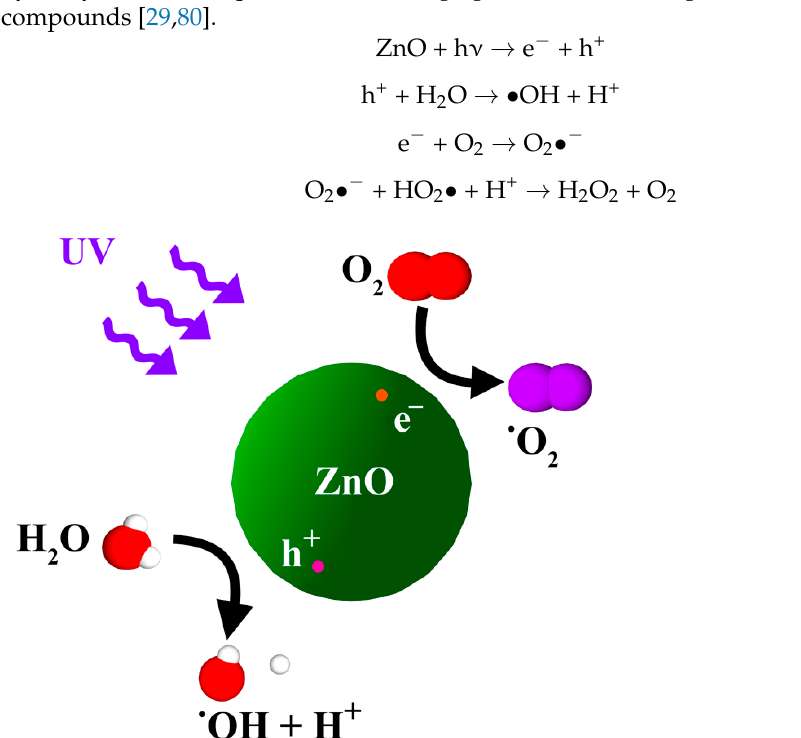
Figure 2. UV-induced photocatalytic activity of ZnO in the presence of O 2 and H 2 O with consequent production of superoxide and hydroxyl radicals.